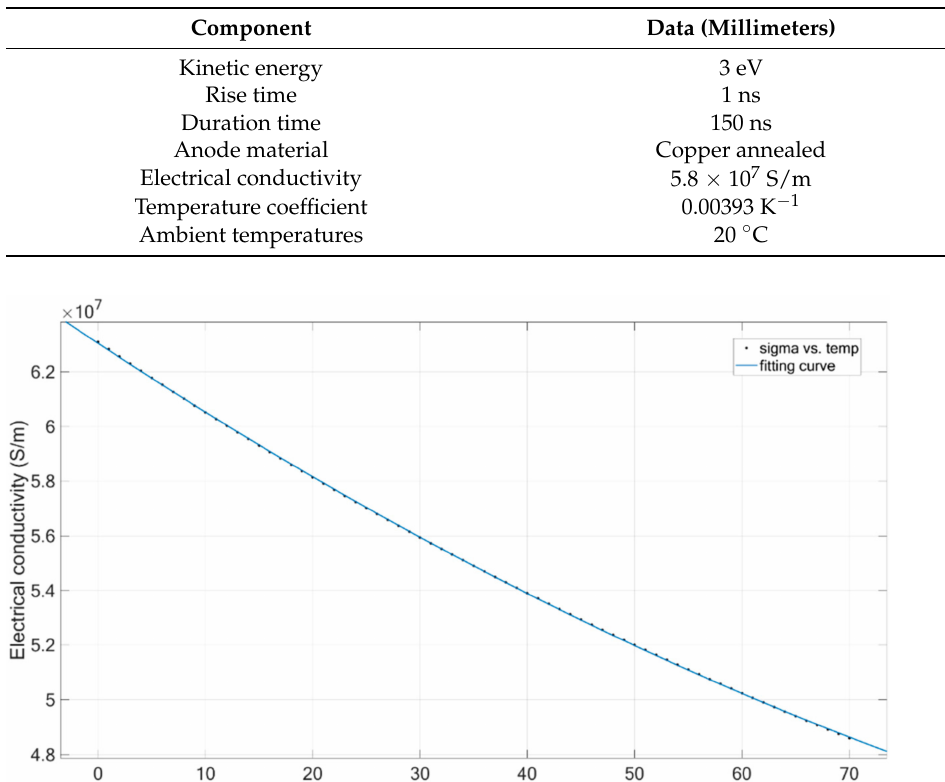
Figure 15. The result of resonant frequency for each mode of magnetron operation. Table 4. The initial conditions of the simulation by Particle-In-Cell.